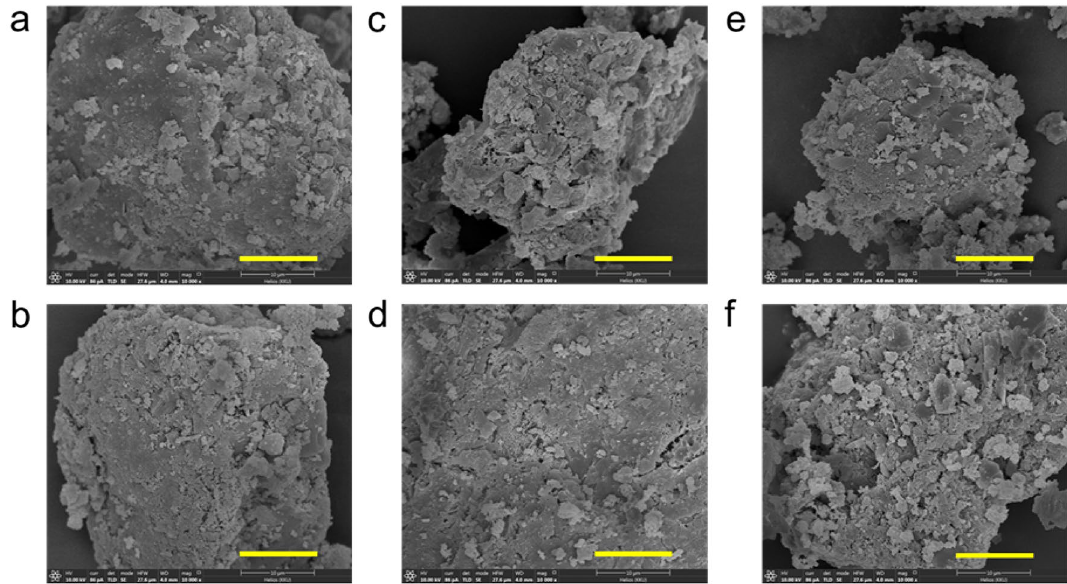
Figure 5. SEM micrographs (10,000X magnification) of cementitious composites at the age of 28 days; ( a ): OPC, ( b ): OPC+WH, ( c ): OPC+IWFC, ( d ): OPC+IWFC+WH, ( e ): OPC+IBFC and ( f ): OPC+IBFC+WH.